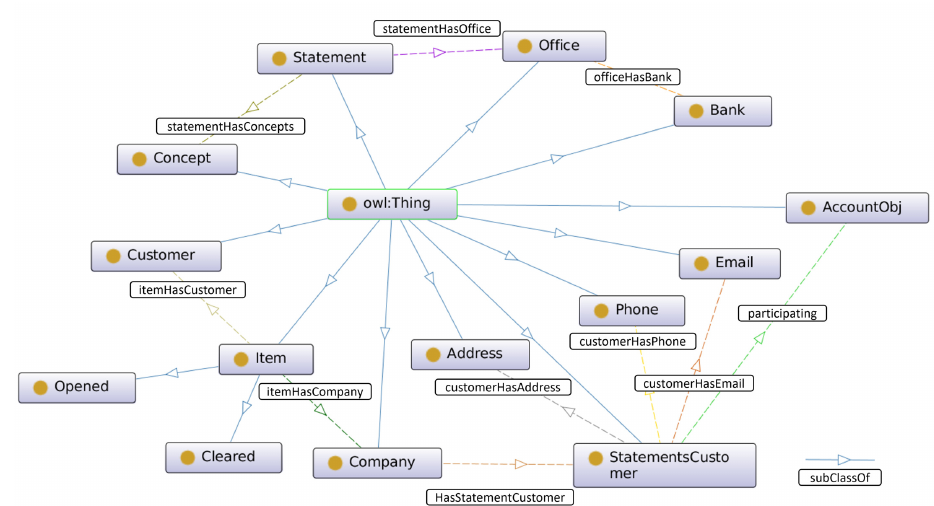
Figure 1. General overview of the Open Banking Ontology proposed in this